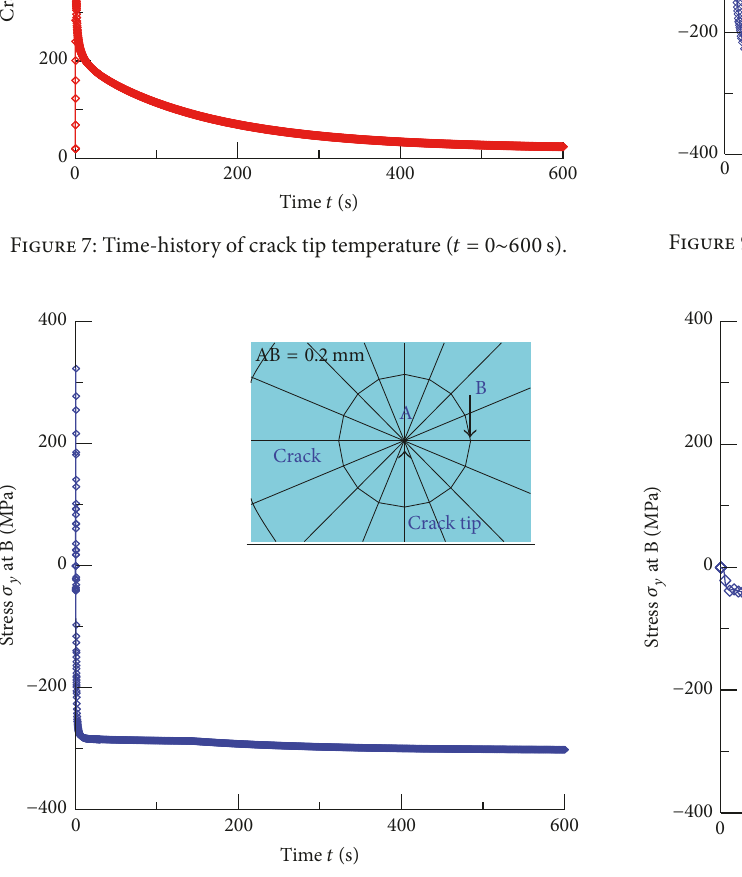
Figure 10: Time-history of stress near crack tip ( 𝑡 = 0 ∼ 2.5